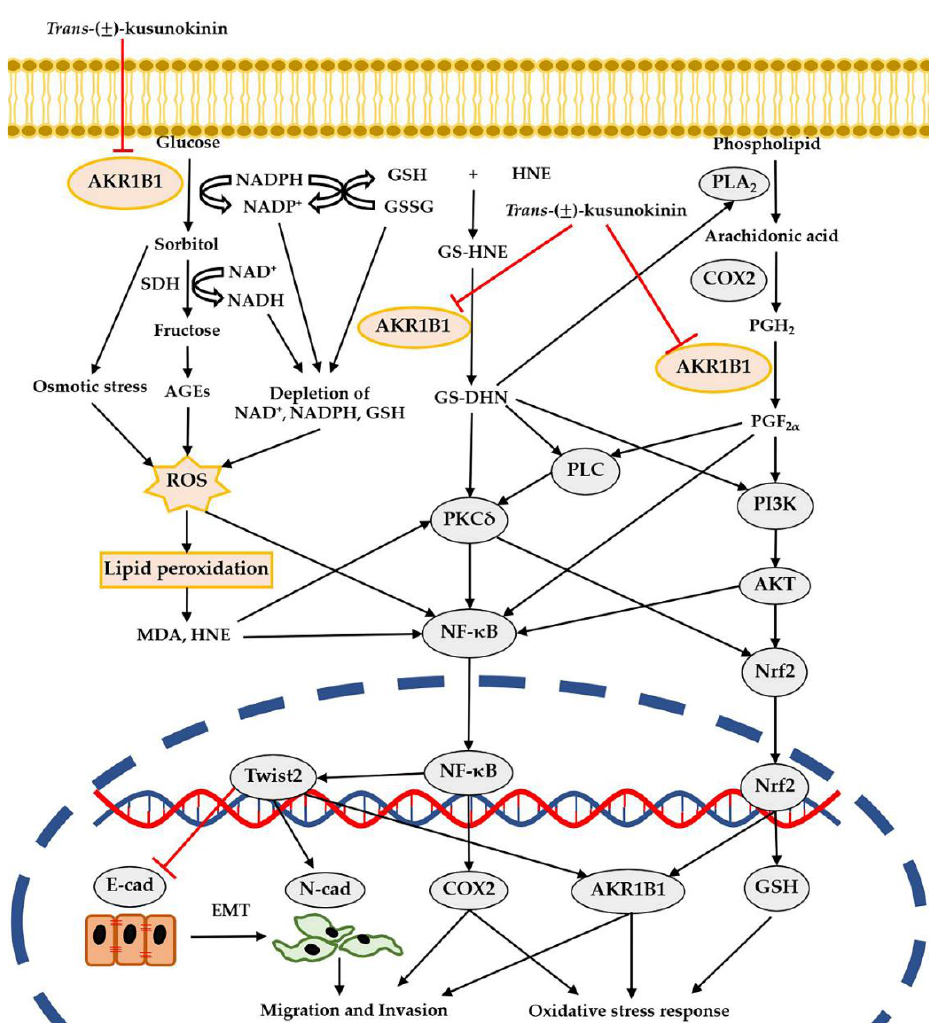
Figure 8 . Schematic illustration of the proposed action of trans -( ± )- kusunokinin on aggressive breast Figure 8. Schematic illustration of the proposed action of trans -( ± )-kusunokinin on aggressive cancer . breast